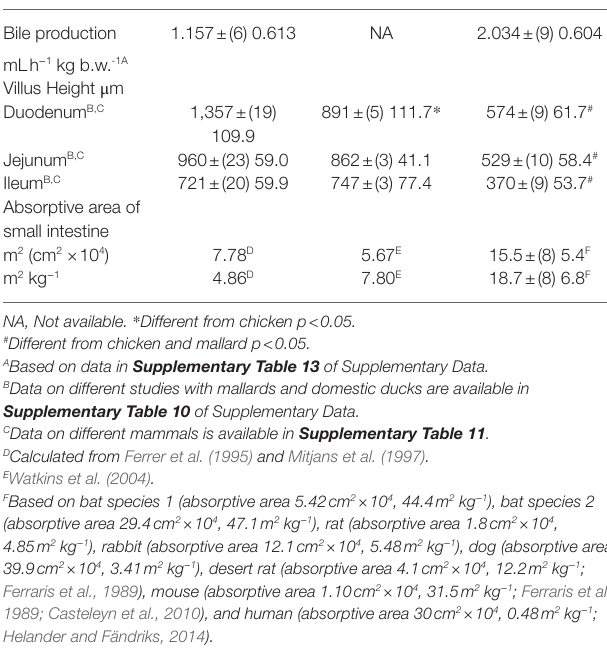
Gastro-intestinal parameters